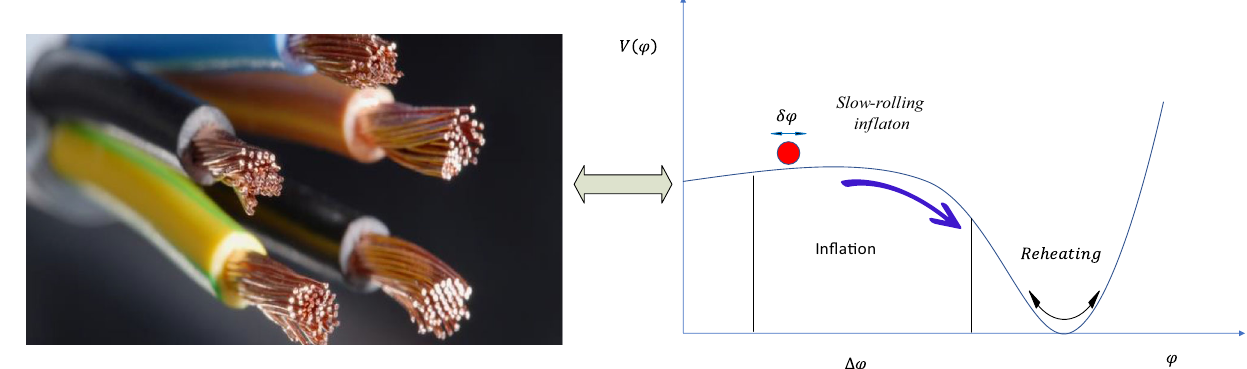
Fig. 1 This schematic diagram shows the correspondence between the conduction phenomena in electrical wires with impurity to that of the cosmological random particle-creation events during the non-adiabatic stage of the early